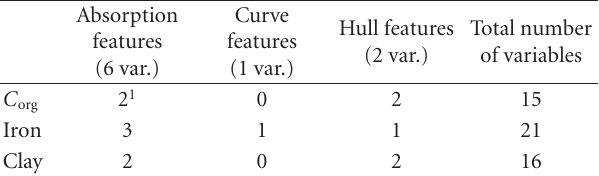
Table 2: Number of spectral features used and total number of calculated variables for determination of key soil